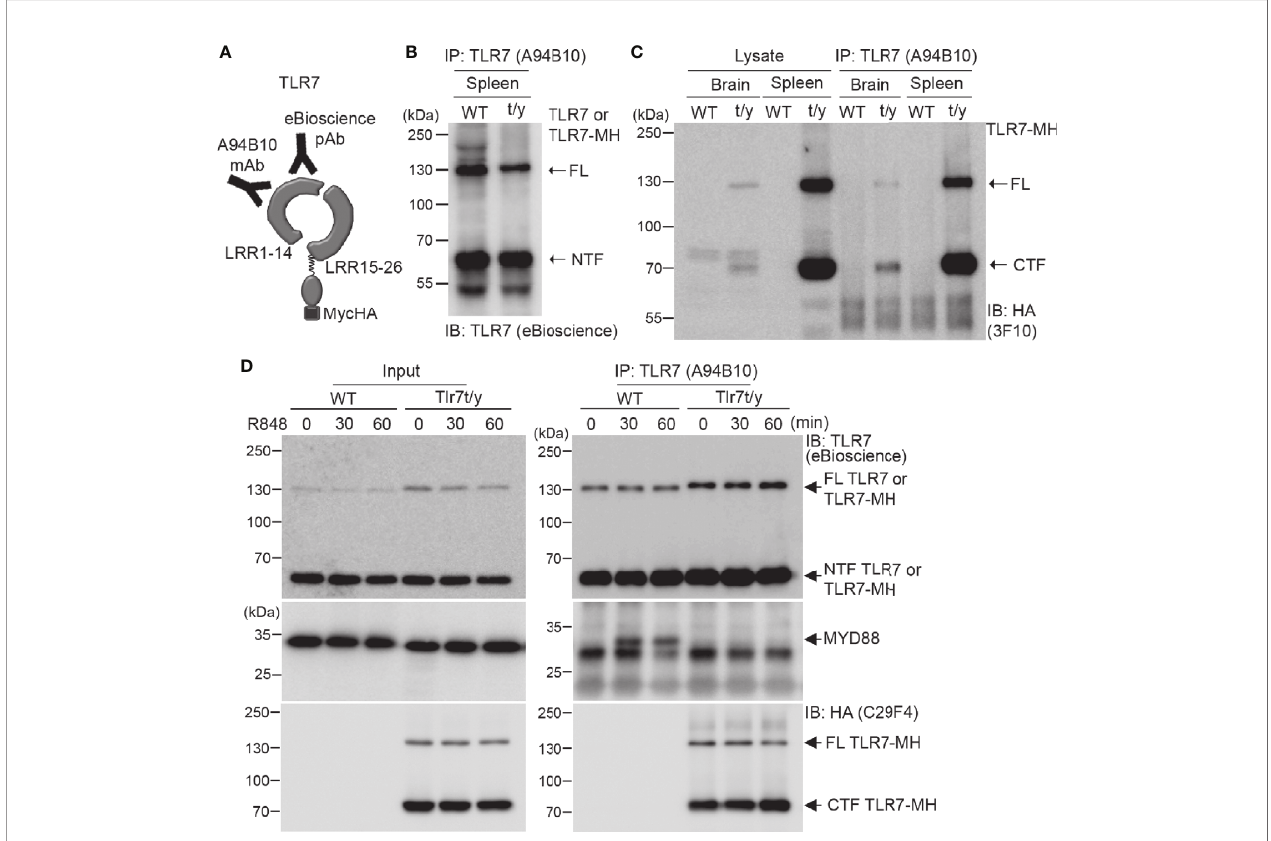
FIGURE 7 | Dual C-terminal Myc-HA tagging disrupts the interaction between TLR7 and MYD88. (A) Schematic of TLR7 protein with the dual C-terminal Myc-HA tag. Monoclonal anti-TLR7 antibody (A94B10) and polyclonal TLR7 antibody both target the N-terminal region. (B, C) The N-terminal (NTF) and C-terminal (CTF) fragments of TLR7 remain associated with each other after proteolytic cleavage. TLR7 was immunoprecipitated (IP) using anti-TLR7 antibody (A94B10) from brain and spleen lysates of WT and Tlr7 t/y mice. The IP complex was then subjected to immunoblotting (IB) analysis using anti-TLR7 antibody (eBioscience) (B) or anti-HA antibody (3F10) (C) . (D) WT and Tlr7 t/y BMDMs were treated with a TLR7 agonist (R848) for 30 and 60 min. Cell lysates were then collected and subjected to IP using anti-TLR7 antibody (A94B10). The IP complex was then analyzed by IB using anti-TLR7 (eBioscience) (upper panel), anti-MyD88 (middle panel), and anti-HA (C29F4, lower panel) antibodies. FL,